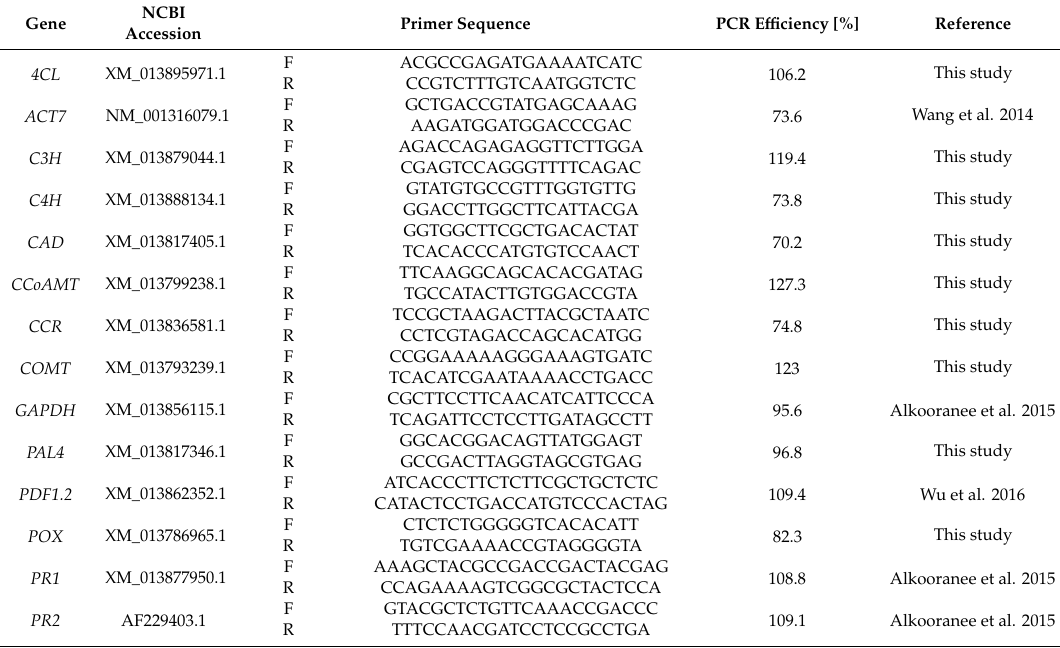
Table 4. Primers used for reference and candidate genes in the biosynthetic pathway of salicylic acid and